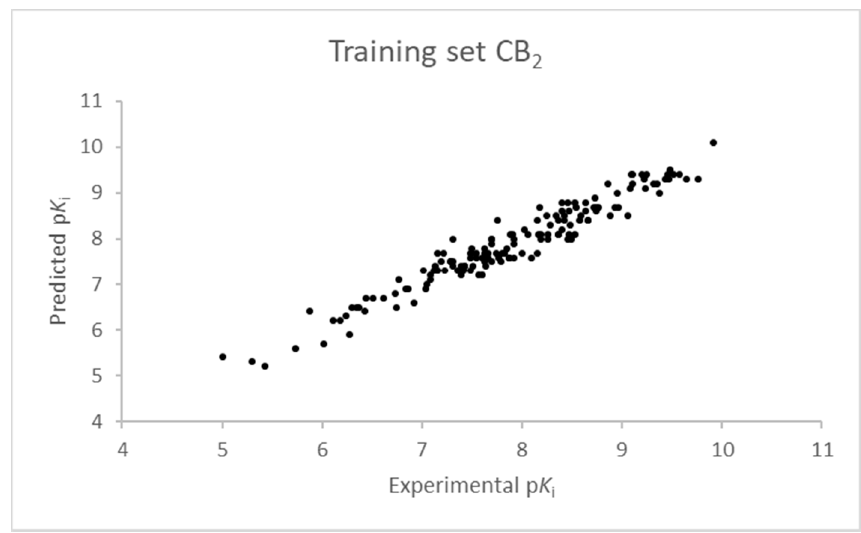
Figure 4. Seven component 3D-QSAR model experimental vs. predicted p K i of the compounds in the training set for the CB 2 receptor.